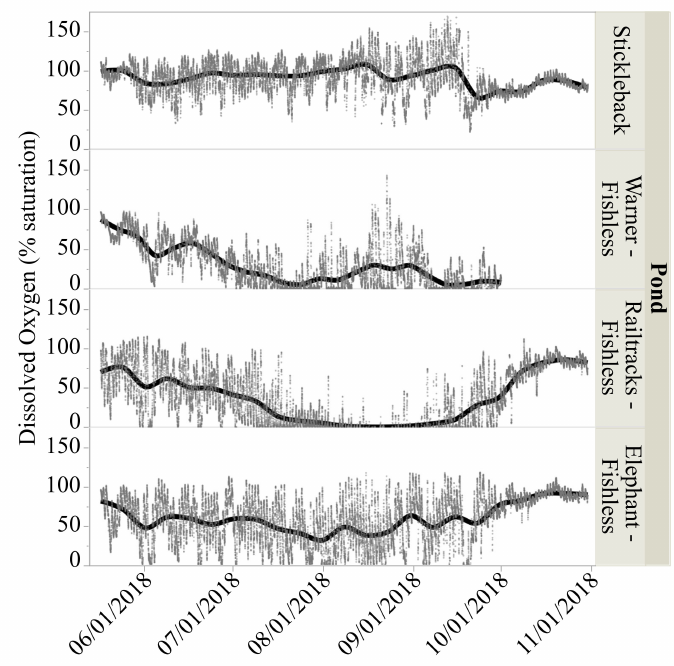
Figure 7. Percent dissolved oxygen from four ponds in east-central Minnesota, USA. Fitted curves are cubic splines with a λ of